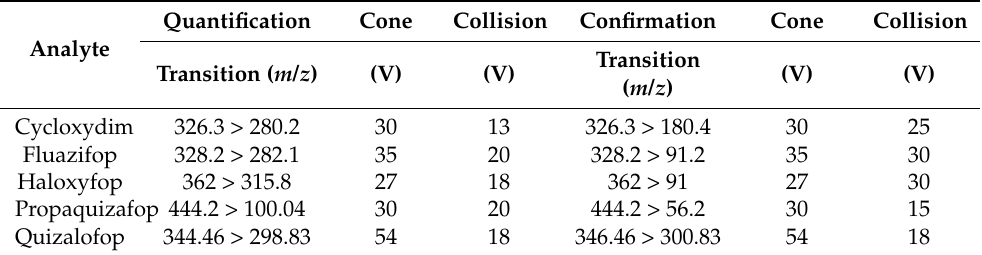
Table 4. Mass spectrometric detector setting.